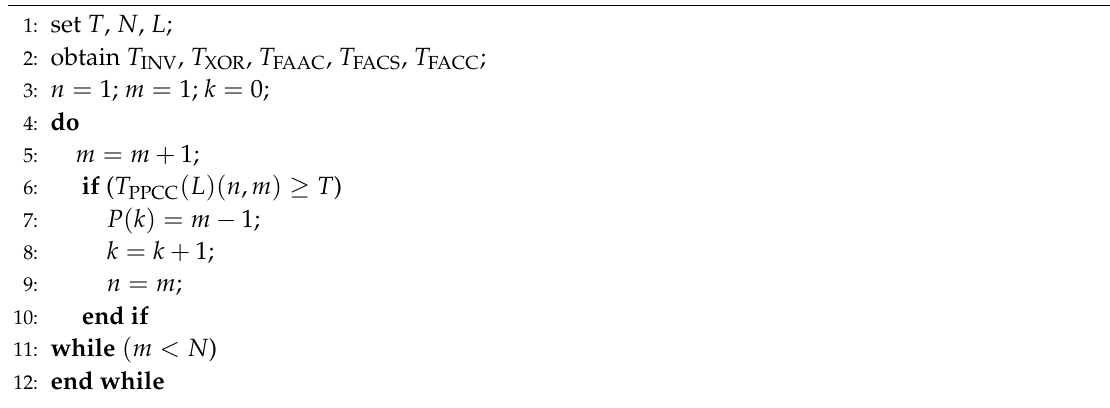
Algorithm 1 Searches the locations of pipeline registers